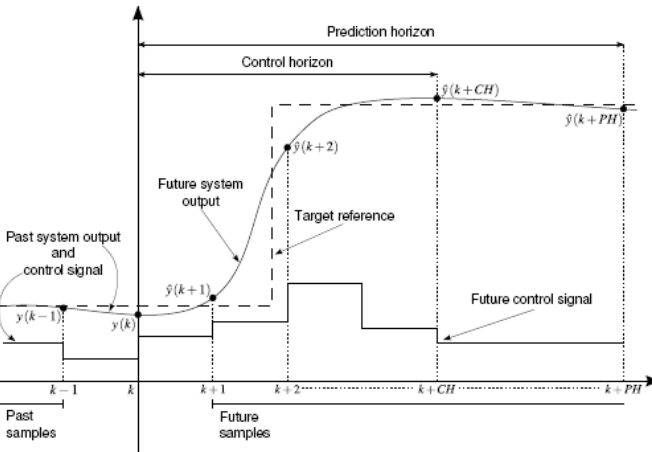
Figure 10. Model-based predictive control strategy [41].